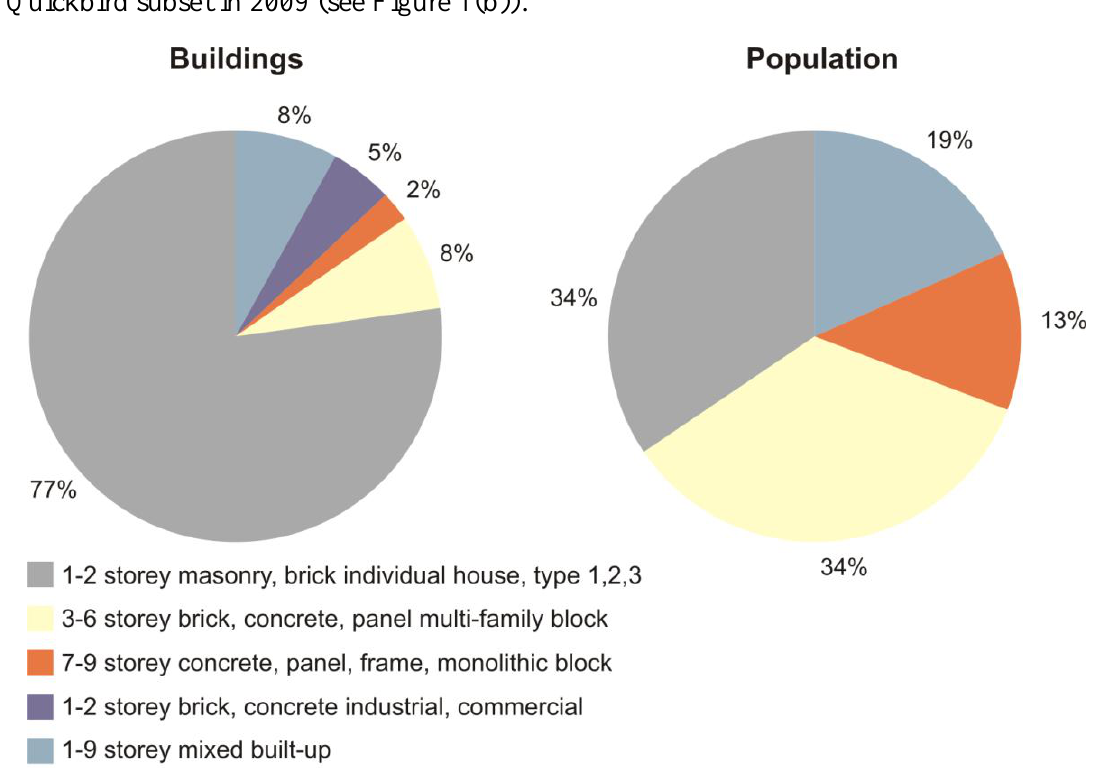
Figure 9. Composition of the number of buildings and population per building type for the Quickbird subset in 2009 (see Figure